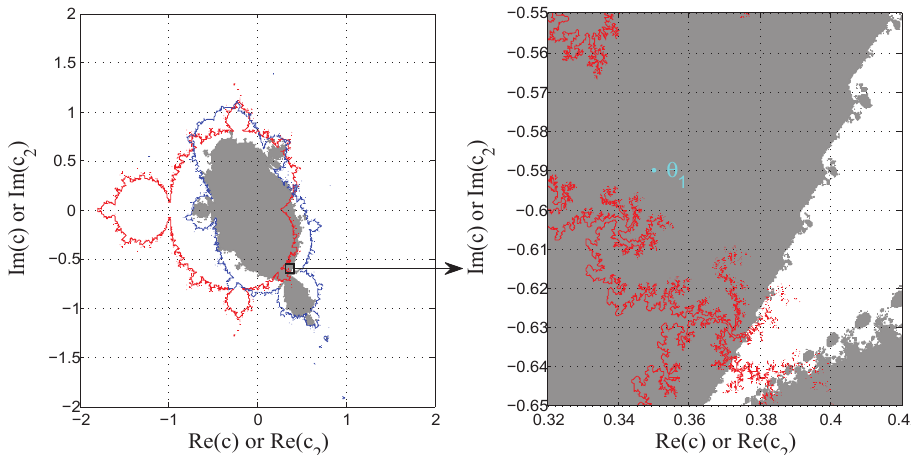
Figure 6. The boundary of M ( P c ) and two slices of M ( P ) .